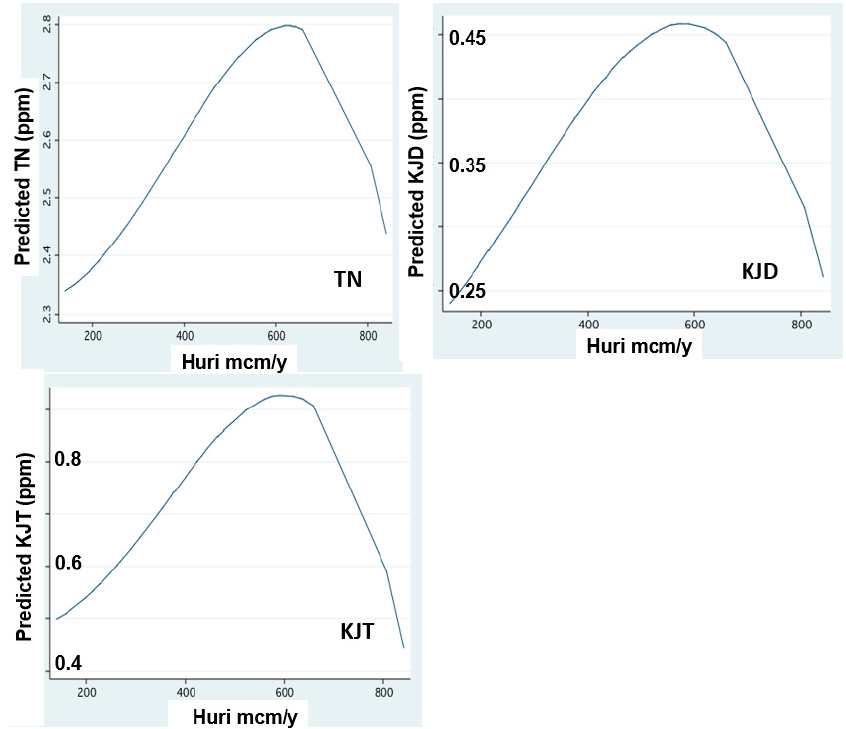
Figure 6. Nitrogen form concentrations in relation to Jordan discharge: FP regression between annual (1970–2018) mean concentrations (ppm) of Total Nitrogen (TN), Kjeldhal Dissolved (KJD) and Kjeldhal Total (KJT)in Jordan waters and annualJordan discharge (mcm/y).